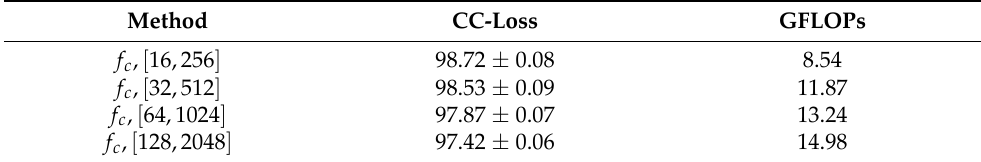
Table 5. Test results under different channel numbers of the weighting